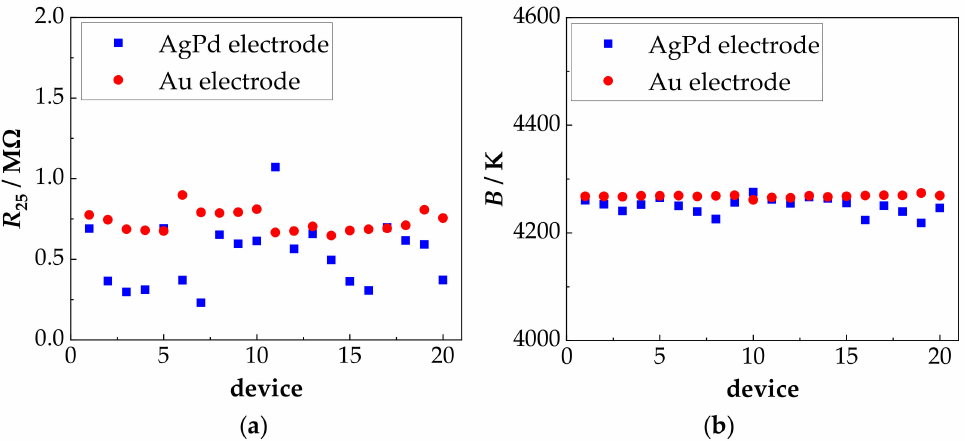
Figure 4. ( a ) R 25 value and ( b ) B value of 20 devices with AgPd electrode and 20 devices with Au electrode in the as-deposited state.